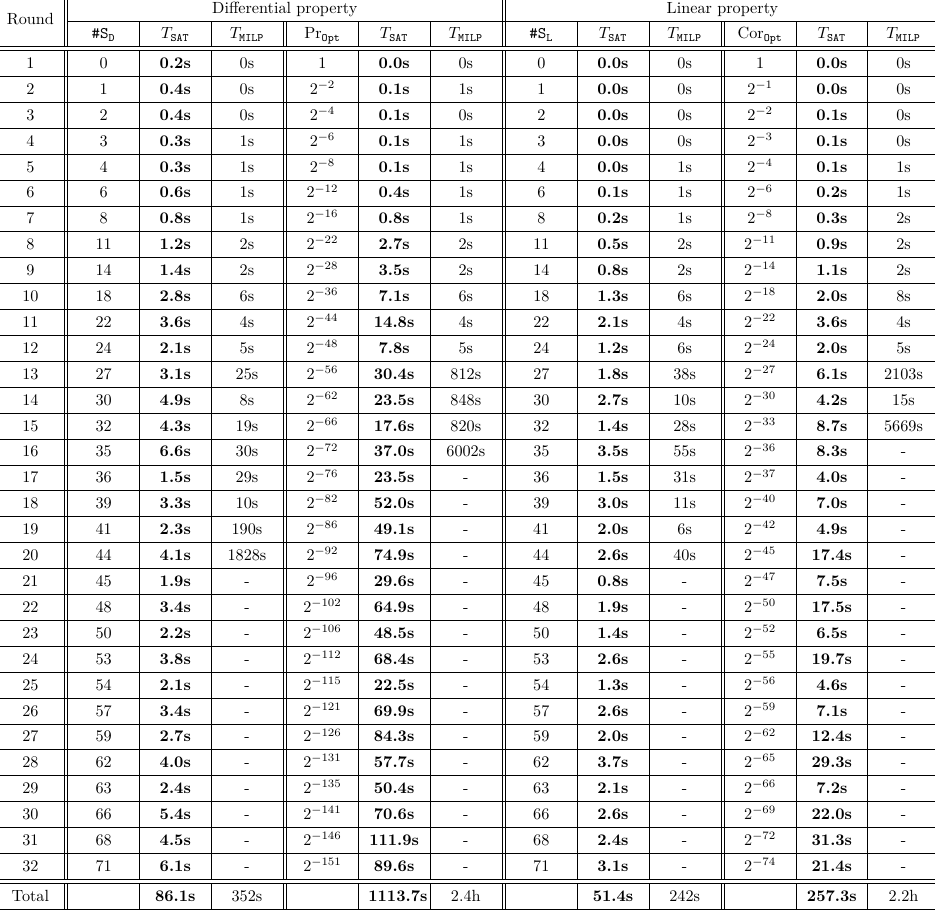
Table 7: Experimental results of LBlock